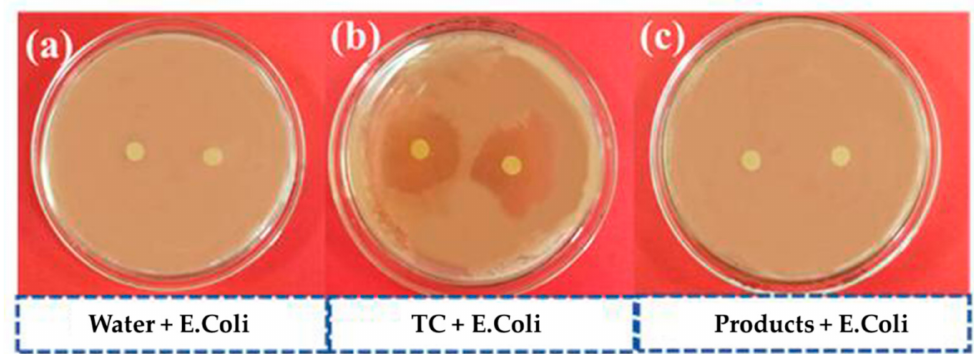
Figure 6. Toxicity assessment of ( a ) distilled water, ( b ) 50 mg/L TC and ( c )products. The products came from TC degraded by F-BFTOC for 120